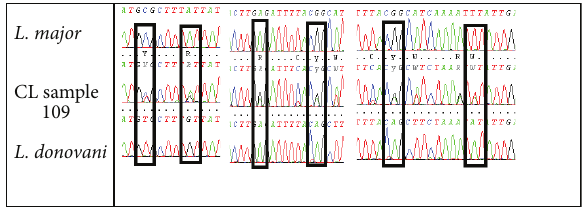
Figure 2: Schematic demonstration of COII sequences obtained by direct sequencing of one CL isolate (sample number 109) showing overlapping of nucleotides in positions 93, 99, 153, 159, 162, and 173 (position according to L. donovani GenBank accession number AY660023); CL sequence compared to L. major MON 25 and to our 3HBM sequence that gave 100% identity to L. donovani (GenBank accession number AY660023).